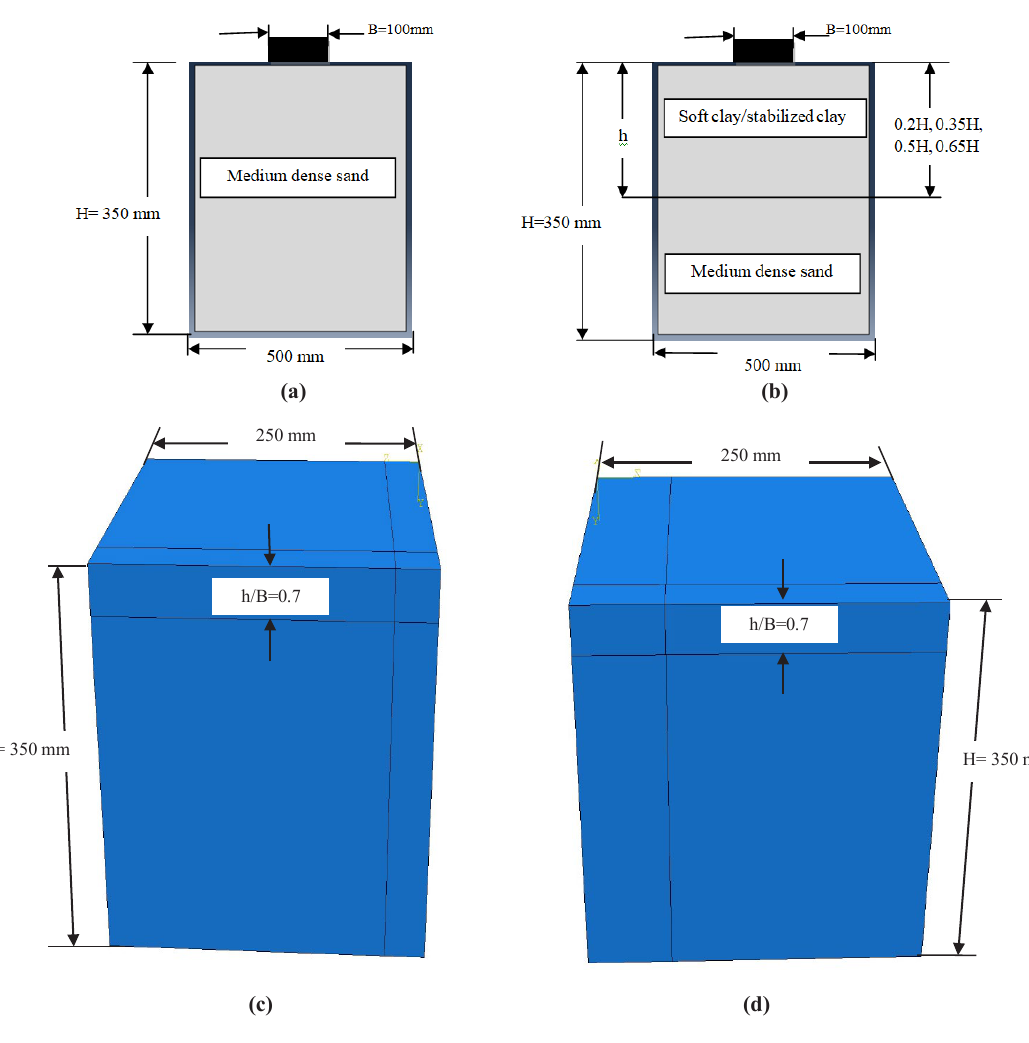
Figure 1: Problem definition . (a) Single layer; (b) thickness of top layer varying at h/B=0.7, 1.225, 1.75, and 2.275; (c) FEM model of footing for aspect ratio (L/B) =1 at h/B=0.7; (d) FEM model of footing for aspect ratio (L/B) =2 at h/B=0.7. h: thickness of the upper layer in two- layered soil; L, B:length and width of footing, respectively Note: all dimensions are not to